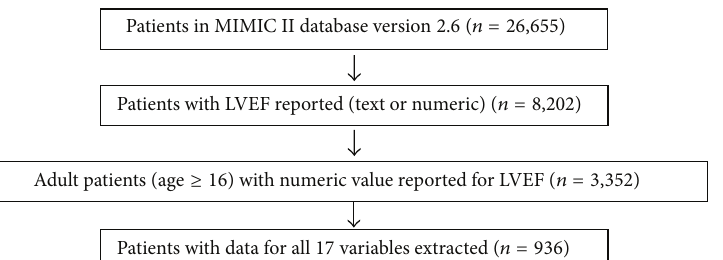
Figure 1: Flow chart of inclusion criteria and number of patients used to define the cohort. LVEF indicates left ventricular ejection fraction; ICU indicates intensive care unit.